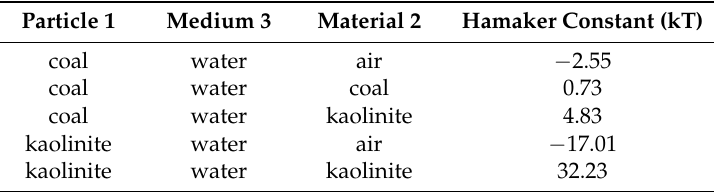
Table 5. The Hamaker constants of two materials in water.